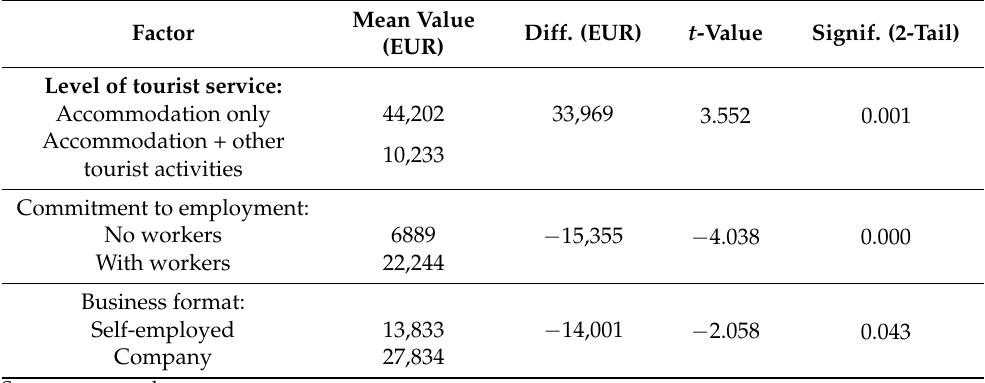
Table 1. Comparison of mean values of lost turnover during the second quarter of 2020 as a result of the COVID-19 lockdown. Mean Value Diff. (EUR) t -Value Signif. Factor (EUR)